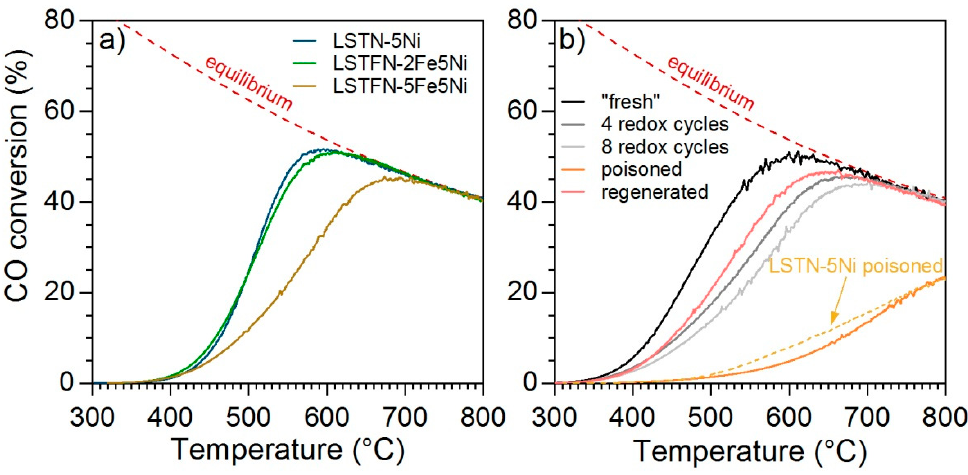
Figure 11. WGS activity of ( a ) reduced LSTN-5Ni, LSTFN-2Fe5Ni, LSTFN-5Fe5Ni (20 vol.% H 2 /Ar, 800 ◦ C, 15 h) and ( b ) LSTFN-2Fe5Ni after eight redox cycles, as well as after poisoning with 50 ppm H 2 S under reaction conditions (poisoned) and after subjecting the material to one further redox cycle (regenerated). Feed gas composition: 15 vol.% CO/15 vol.% H 2 O/7.5 vol.% H 2 /Ar; 30,000 mLh − 1 g − 1 at STP. The calculated theoretical conversion equilibrium is indicated by the dashed red curve.